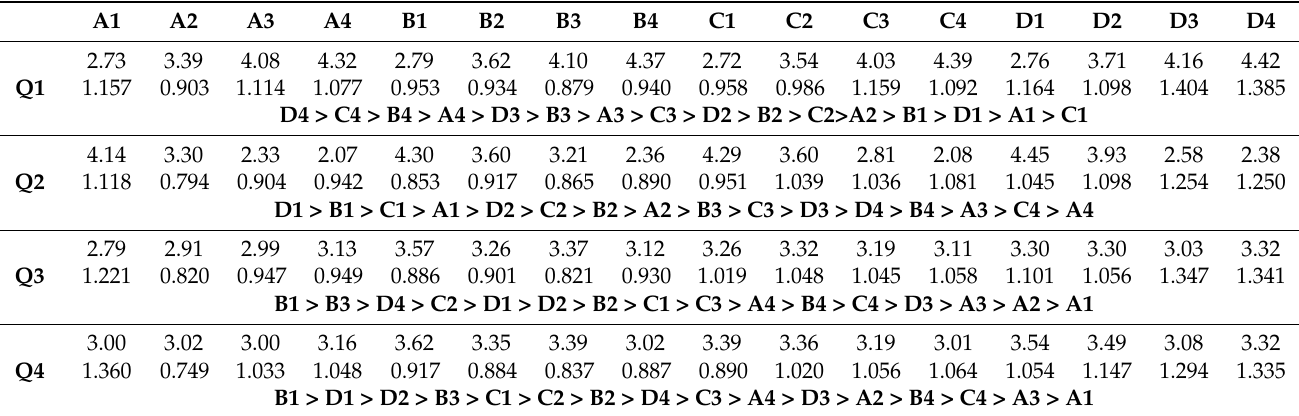
Table 3. The mean and SD of the participant’ responses to the 4 evaluation attributes.